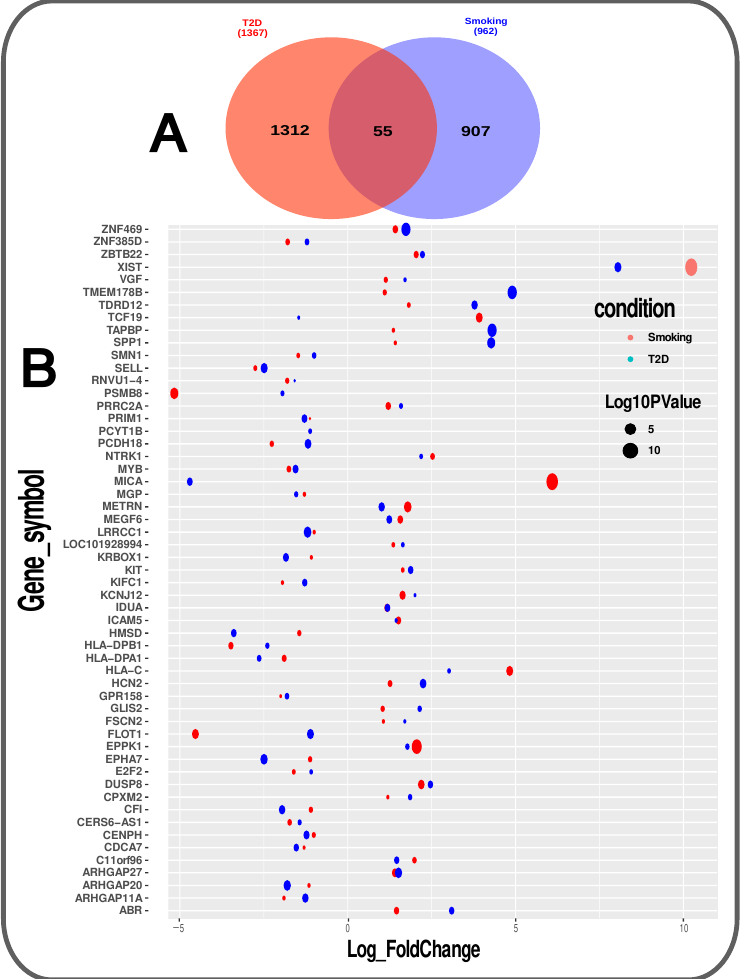
Figure 2. The figure represented the summary of transcriptomic analysis. A . Common biomarker Genes between T2D and Smoking using a venn diagram B . Bubble plot of common biomarker genes and their associated adjusted p -value and Log2 fold